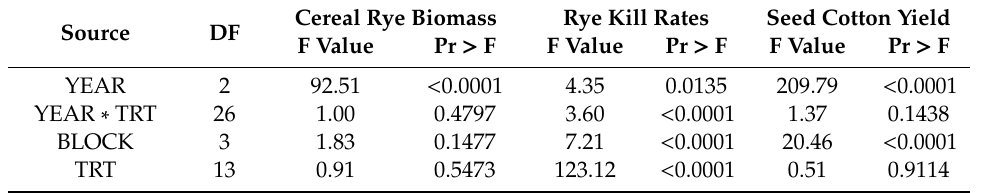
Table 2. Analysis of variance results for cereal rye biomass production, kill rates and seed cotton yield.